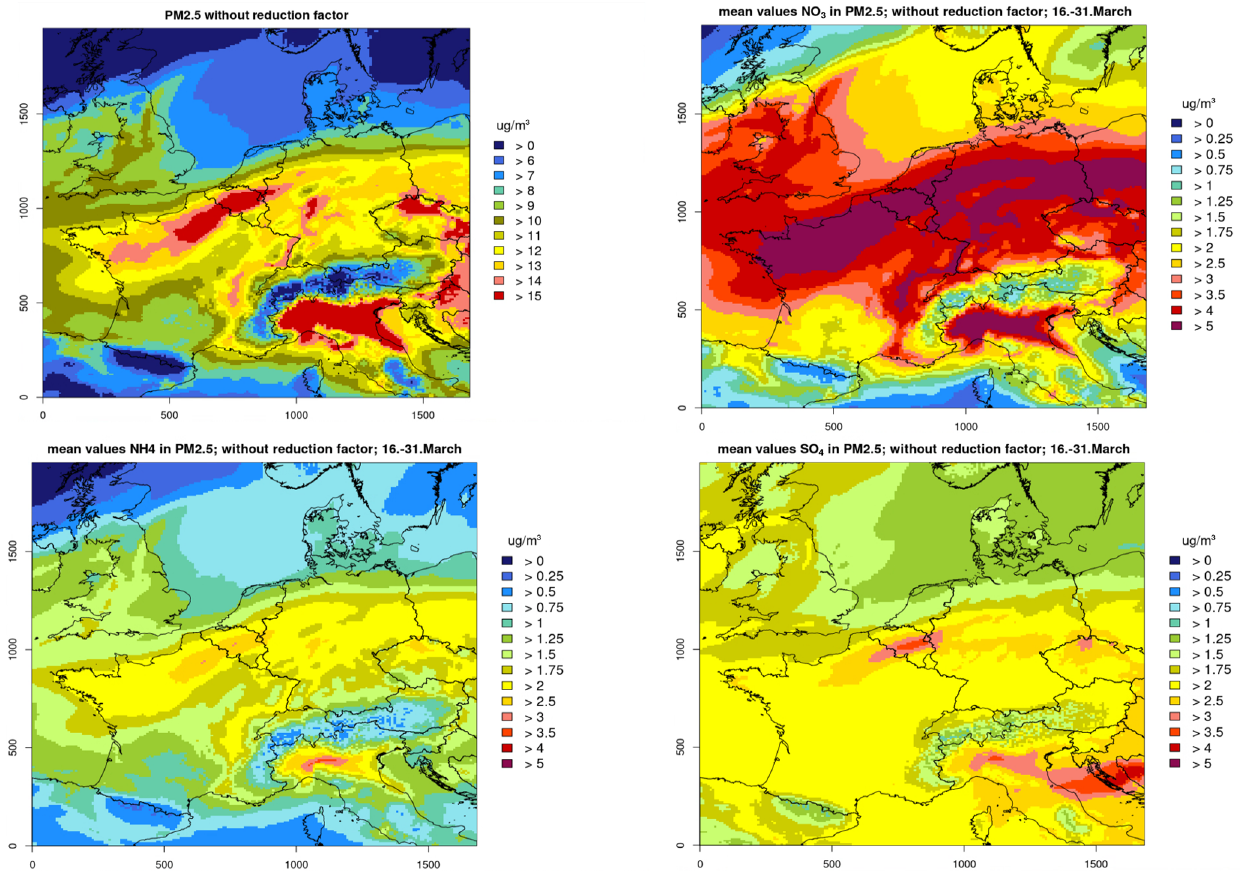
Figure A12. CMAQ results for concentrations of PM 2 . 5 and its components nitrate, ammonium and sulfate in central Europe between